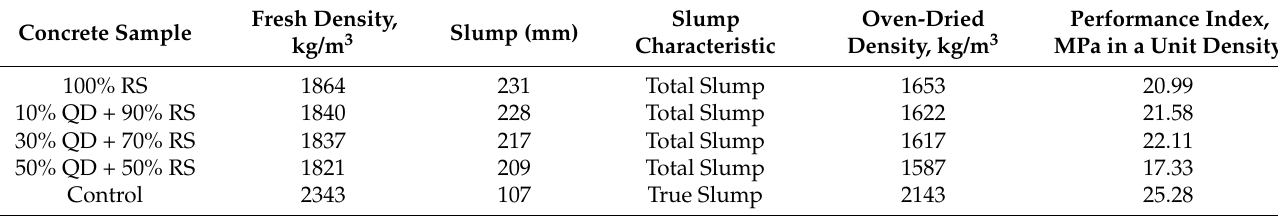
Table 5. Slump results and density measurements for the design mix.